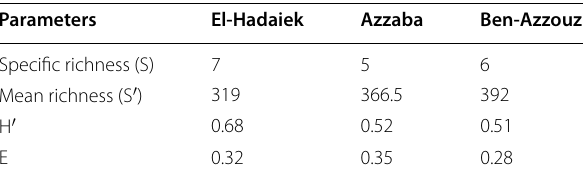
Table 5 Specific and mean richness and Shannon–Weaver diversity (H) and equitability (E) indices of gastropods in the three study sites